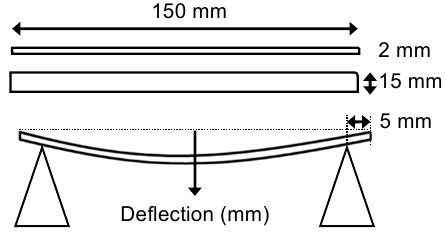
Figure 1. Schematic illustration of the Sag test and sample dimensions.